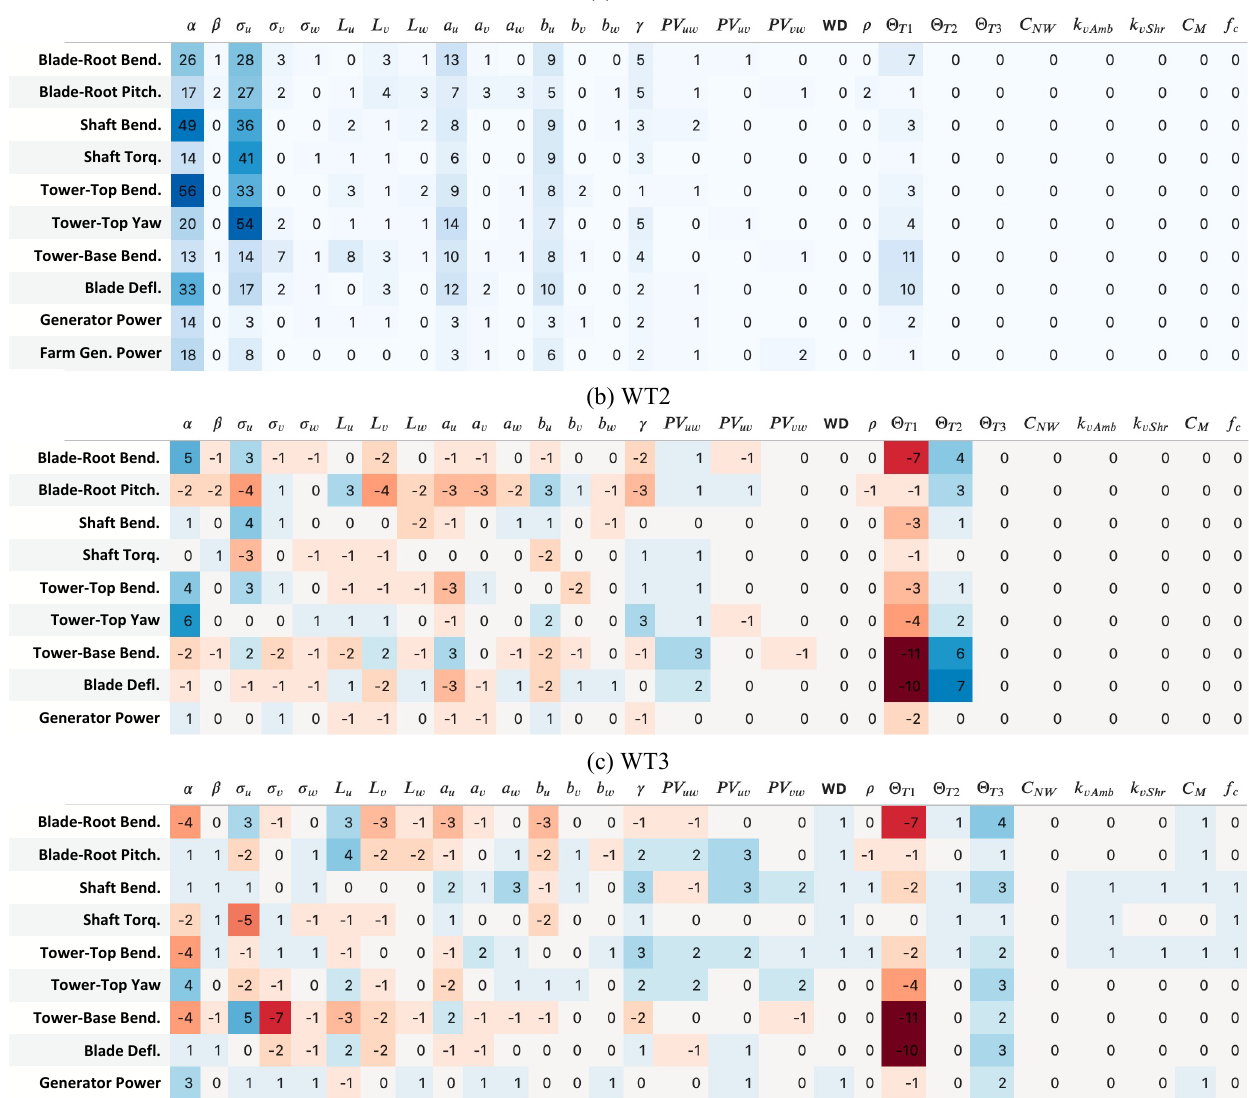
Table 6. Tabulated results for the number of ultimate load significant events for each input parameter, separated by QoI. Cells are colored by the count value, with darker blue representing a more positive count and darker red representing a more negative count. Results for WT1 show the absolute number of significant events, while results for WT2 and WT3 show the number of significant events relative to WT1.